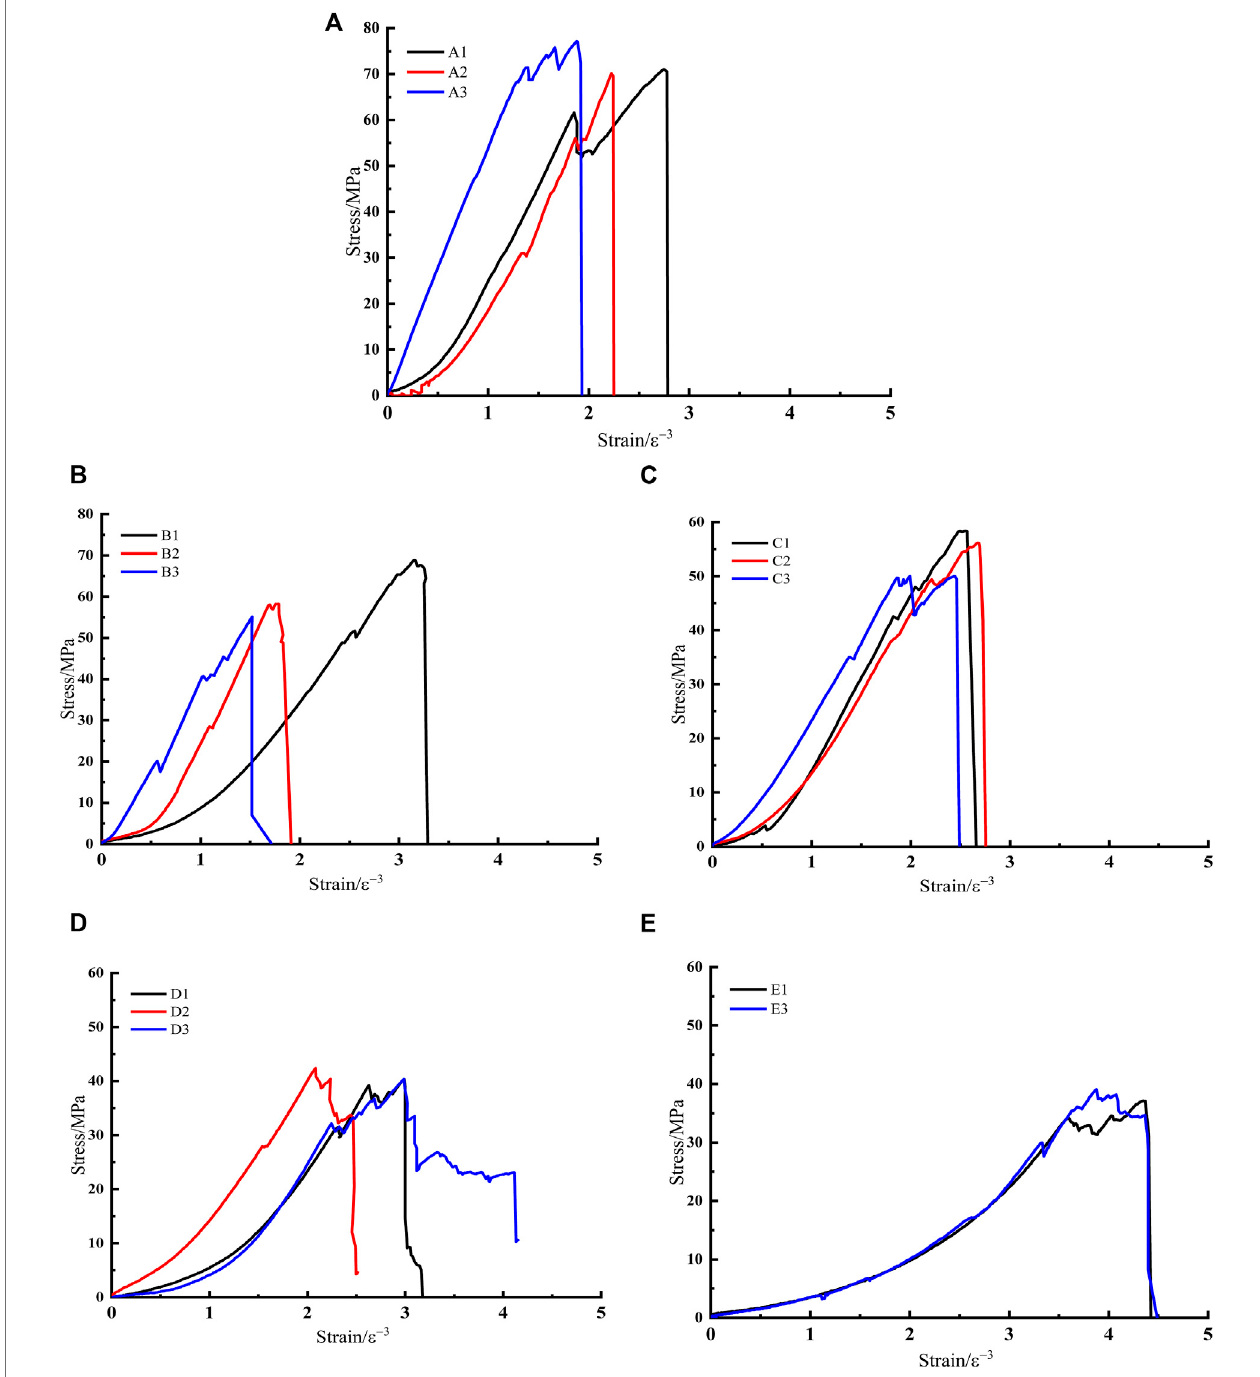
FIGURE 2 | Stress strain curves of jointed limestone with different water saturation times. (A) Dry. (B) 1 day. (C) 3 days. (D) 5 days. (E) 7 days.